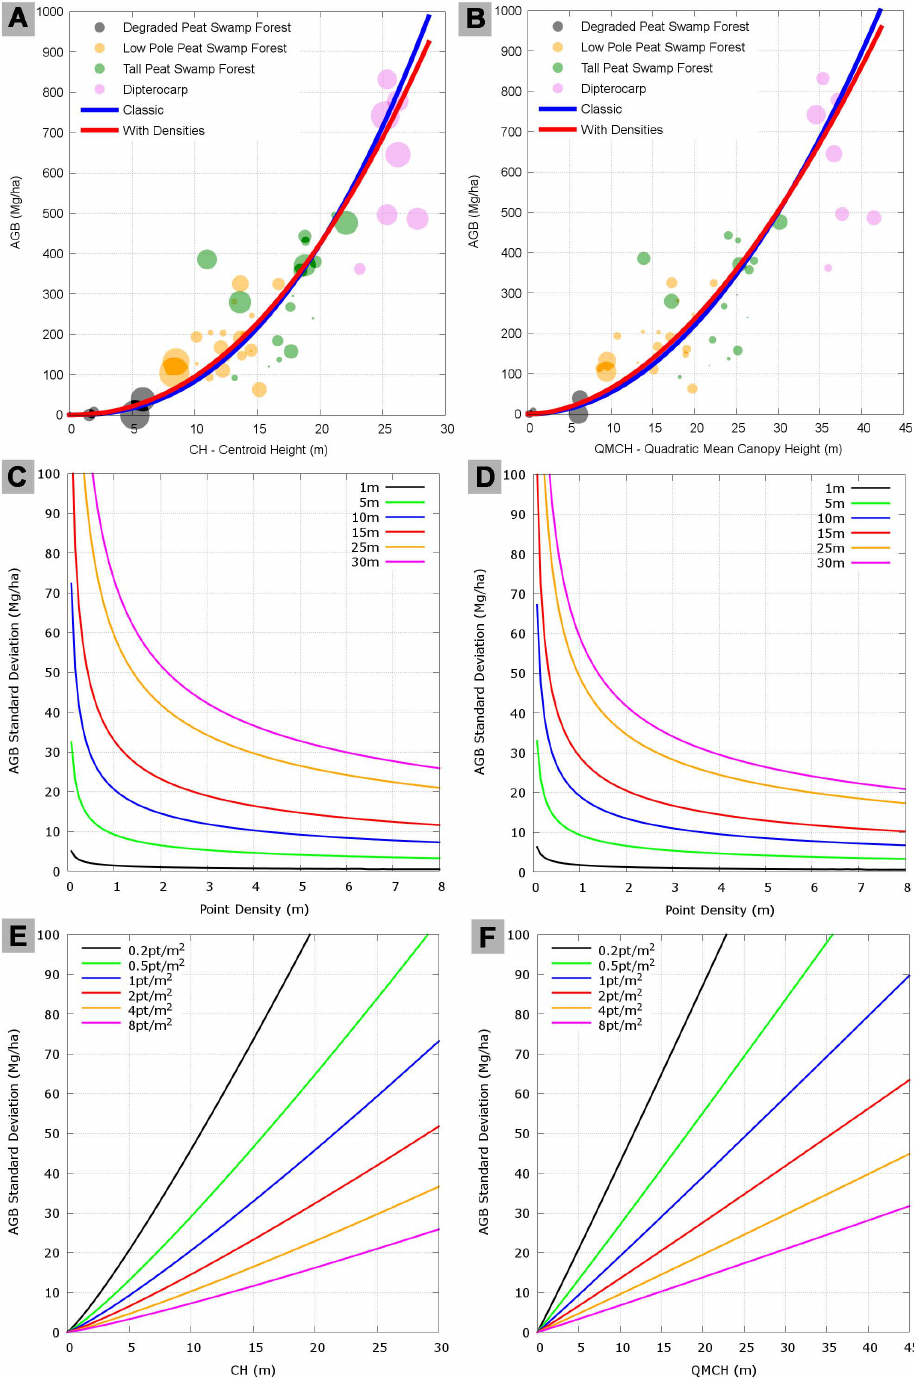
Fig. 4. Biomass regression and error propagation analysis results. (A) In red the centroid height (CH)-based regression model with LiDAR point density weighting (AGB = 0.0865 × CH 2 . 1564 ; R 2 = 0 . 88; root mean square error (RMSE) = ±13.79t 0.13ha − 1 ; predictive power of the regression (PPR) = ±14.98t 0.13ha − 1 ) and in blue without weighting (AGB = 0.0484 × CH 2 . 3494 ; R 2 = 0 . 79; RMSE = ±16.06t 0.13ha − 1 ; PPR = ±17.43t 0.13ha − 1 ) . (B) In red the quadratic mean canopy profile height (QMCH)-based regression model with LiDAR point density weighting (AGB = 0.1150 × QMCH 2 . 0277 ; R 2 = 0 . 84) and in blue without weighting (AGB = 0.0660 × QMCH 1 . 8656 ; R 2 = 0 . 76). The circle size in (A) and (B) represents the point densities (the smallest about 0.2ptm − 2 and the biggest about 3.5ptm − 2 ) . (C) and (D) show standard deviation estimation curves for CH and QMCH due to variation of the point density for diverse values (1m, 5m, 10m, 15m, 20m and 30m). (E) and (F) show the standard deviation estimation curves for CH- and QMCH-based regression models due to variation of CH and QMCH for 6 different point densities (0.2, 0.5, 1, 2, 4 and 8 ptm − 2 )